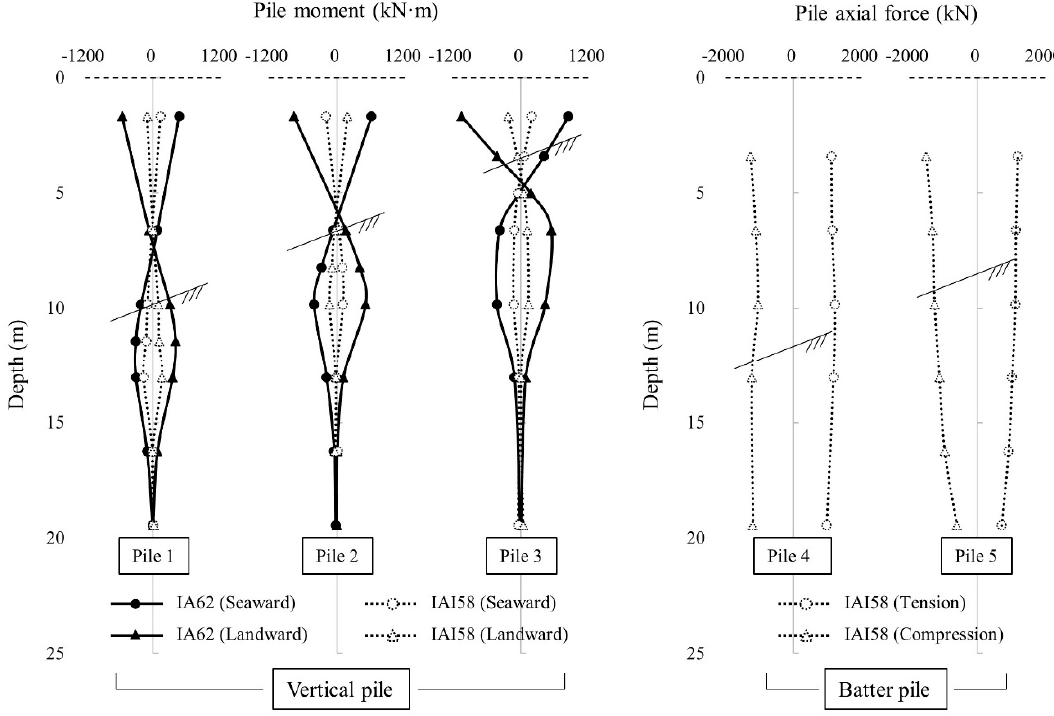
Figure 11. Depth profiles of maximum moment and axial force of inclined ground model (0.12 g) (scaled to the prototype).